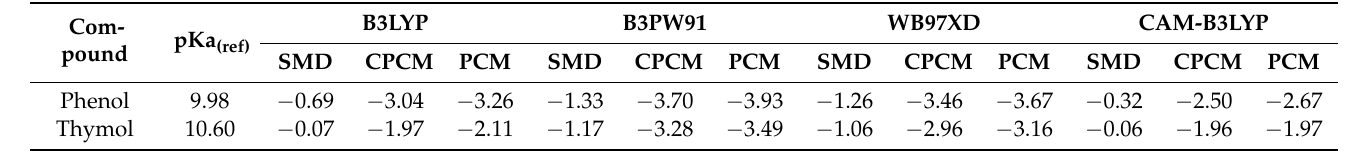
Table 2. ∆ pKa values calculated with one explicit water